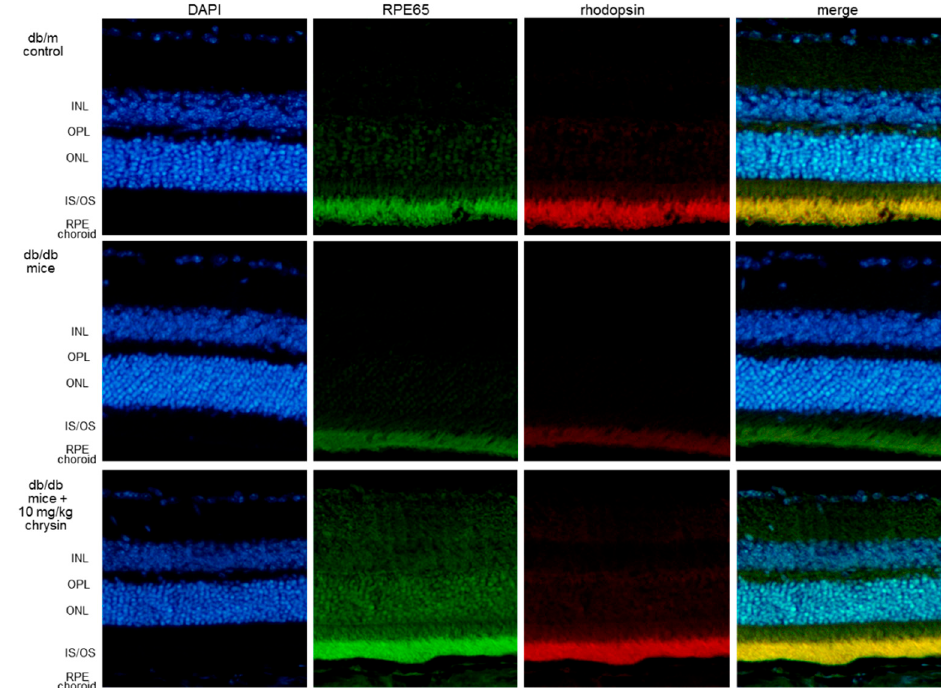
Figure 3. Induction of RPE65 and rhodopsin by chrysin. The db/db mice were orally supplemented with 10 mg/kg of chrysin daily for 10 weeks. The db/m mice were introduced as control animals. Histological sections of mouse retina were immunohistochemically double-stained using a primary antibody of RPE5 and rhodopsin. The RPE65 was identified as fluorescein isothiocyanate (FITC) green staining, and the rhodopsin localization was detected with Cy3 red staining. The sections were counterstained with 4 ′ ,6-diamidino-2-phenylindole (DAPI, blue) for the nuclear staining. The triple staining of DAPI-FITC-Cy3 was merged. Magnification: 200 × . Retinal layers are labeled as follows: inner nuclear layer (INL), outer plexiform layer (OPL), outer nuclear layer (ONL), photoreceptor inner segment/outer segment (IS/OS), and retinal pigment epithelium (RPE).